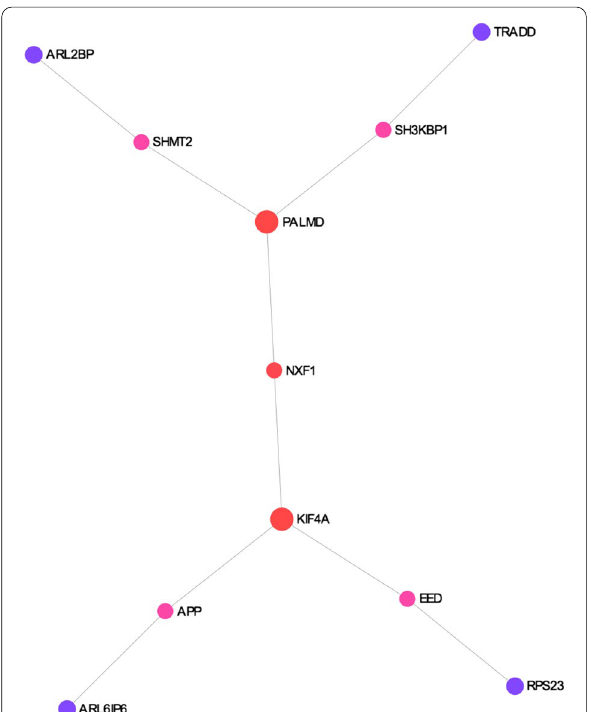
Fig. 2 PPI network analysis for identified significant DEGs. The relationship between blue and red gene encoded proteins is connected by small circles (e.g., NFX1 is between PALMD and